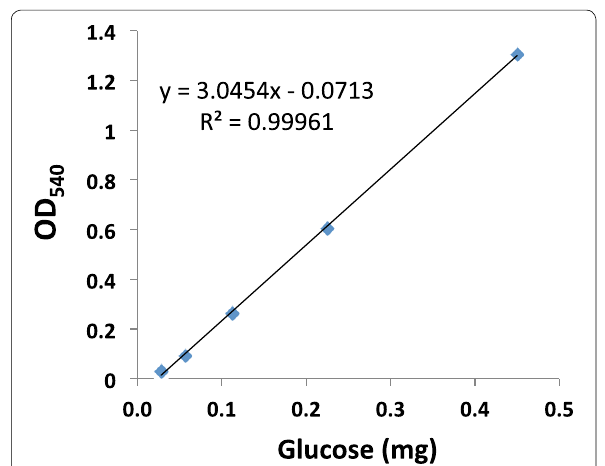
Fig. 1 A standard curve of the glucose assay generated using the dinitrosalicylic acid method